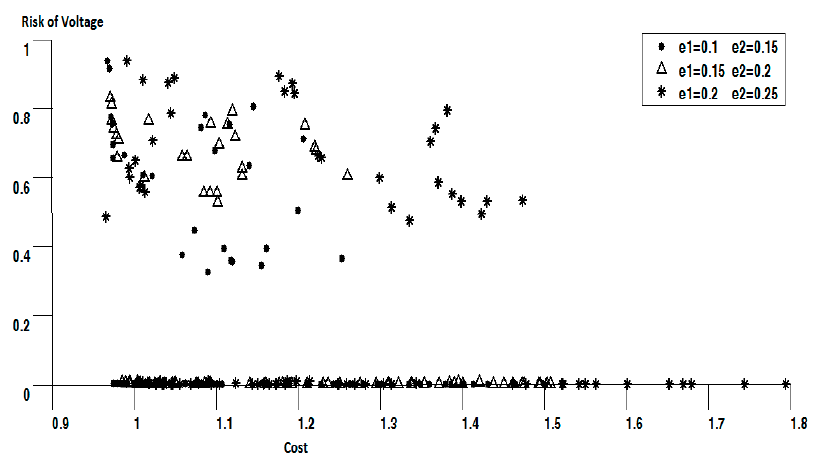
Figure 12. Two-dimensional diagram of economic objective function and voltage risk in various experiments.